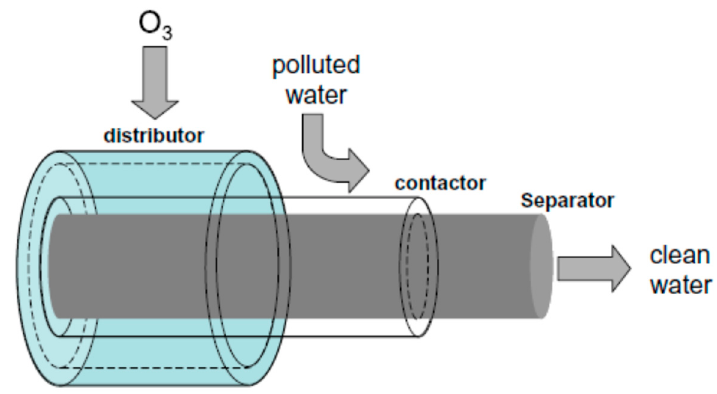
Figure 9. An advanced hybrid ozone membrane distributor/contactor/separator concentrically arranged [92].